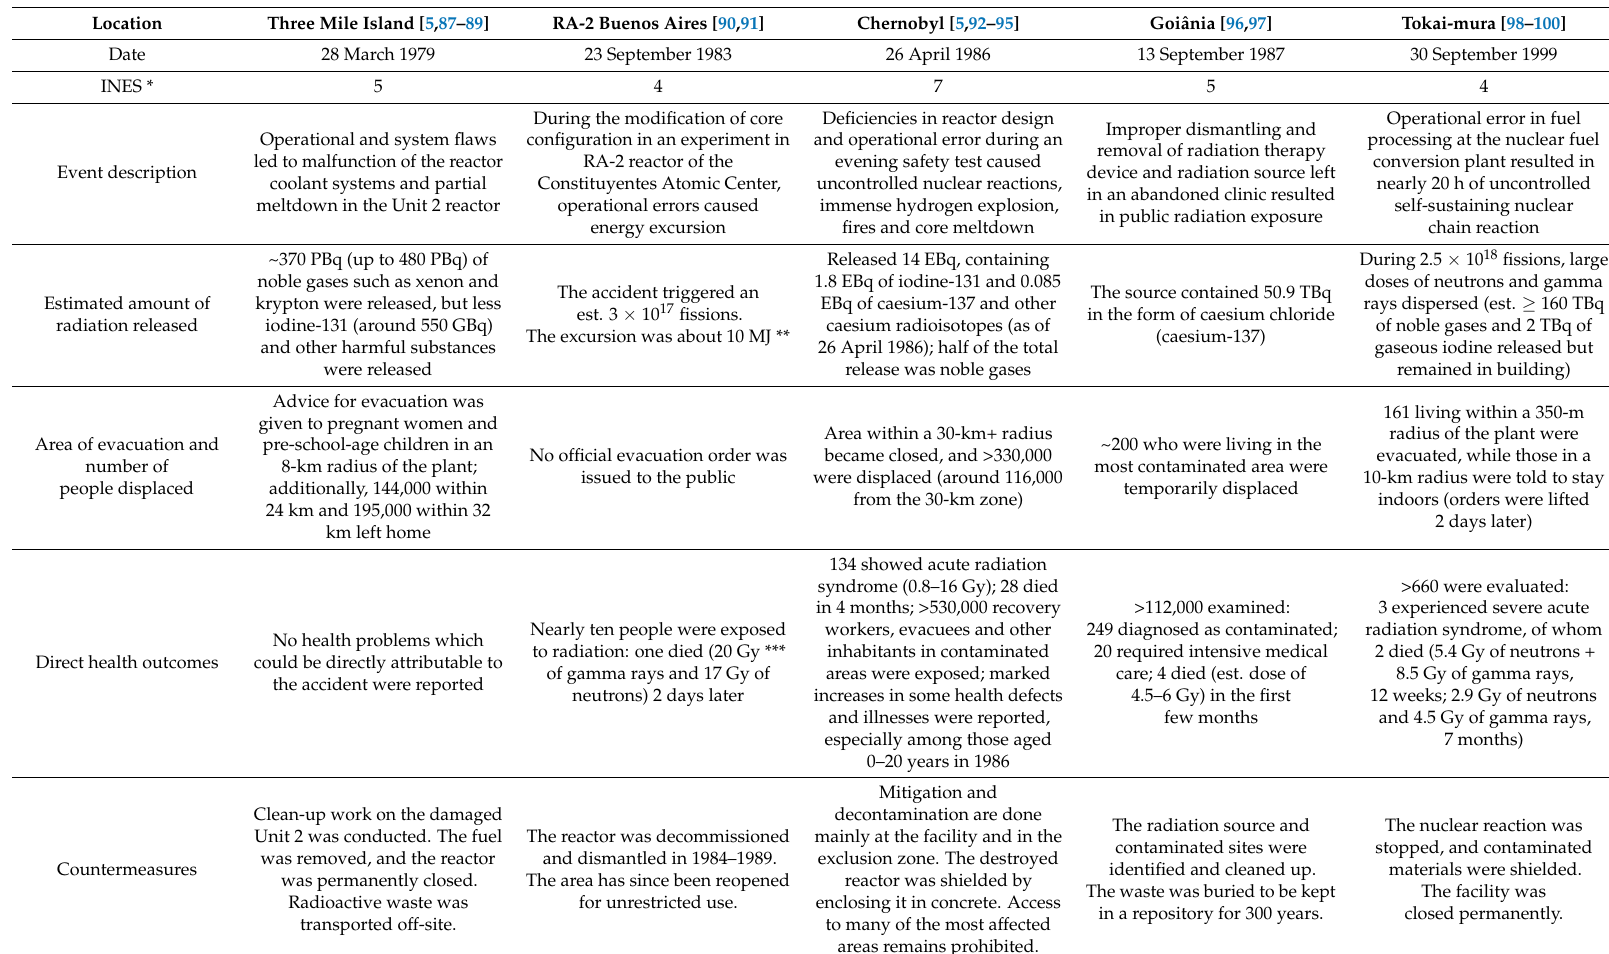
Table 2. Summary of selected nuclear or radiological events in the past few